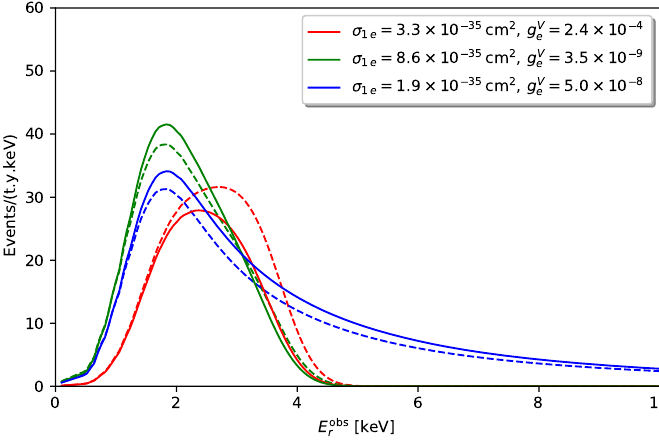
Figure 6 . Sample energy spectra including the ionization factor for the same benchmark mass spectra and particle spins (VF case) as in figure 2. Three dashed curves are the same as those appearing in figure 3, which already incorporate the detector resolution and the detector